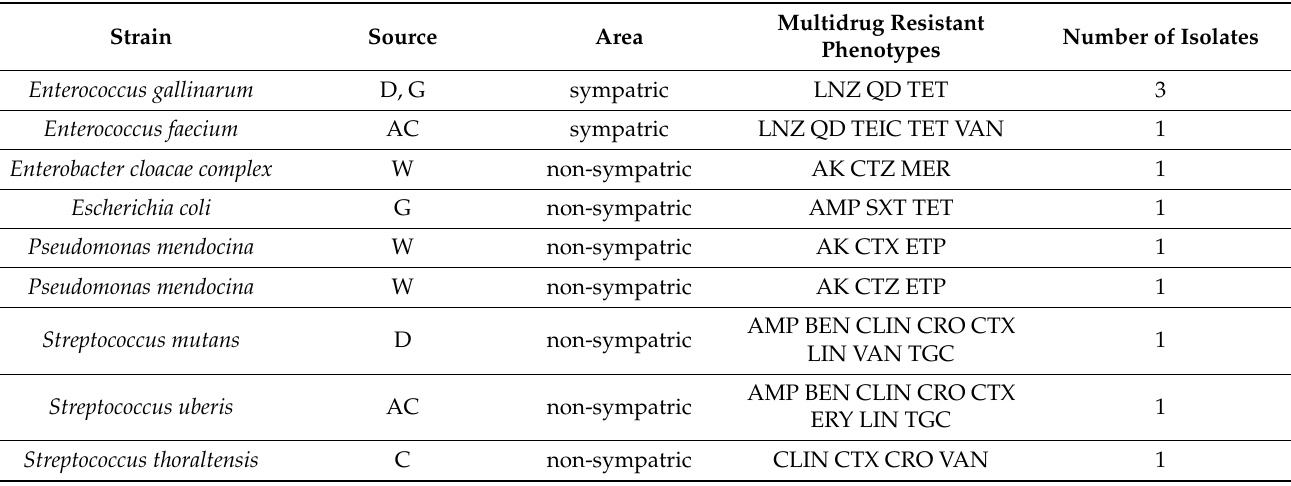
Table 2. Distribution of MDR bacteria isolated from fecal and water samples collected in investigated areas of Maiella National